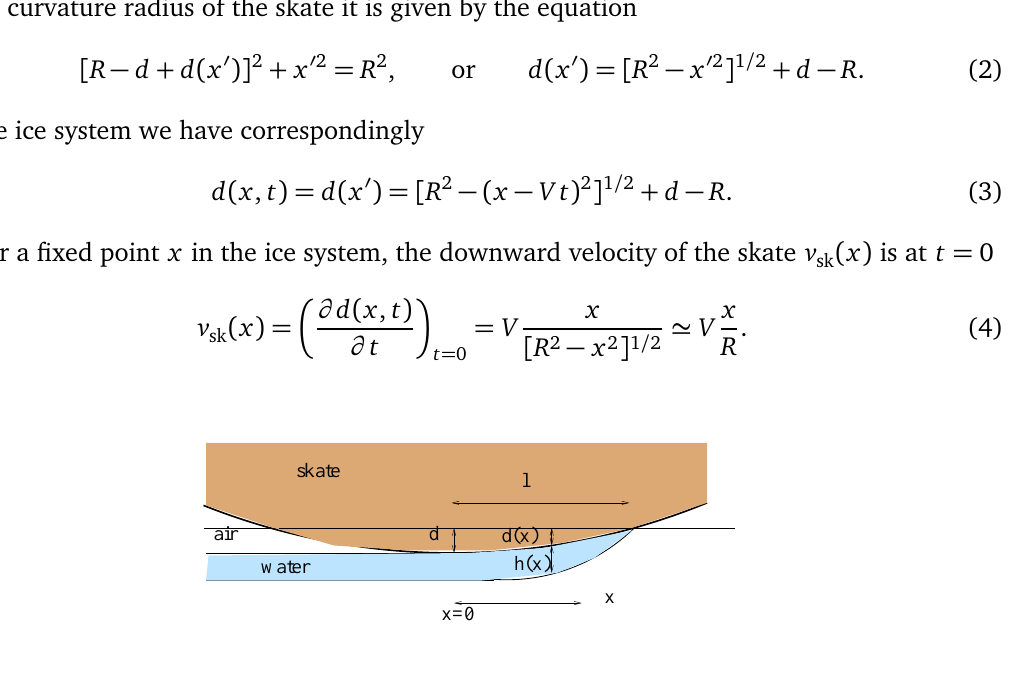
Figure 1: longitudinal cross-section of skate, ice and water layer in